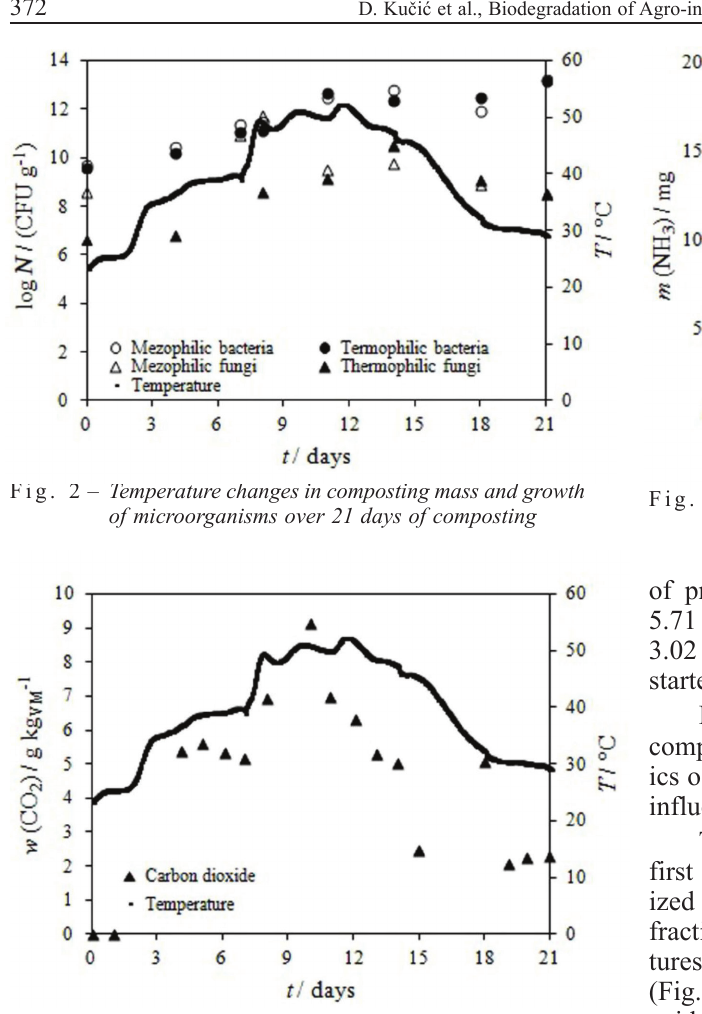
Fig. 3 – Evolution of carbon dioxide versus temperature during composting of mixture of GW, OW and TW